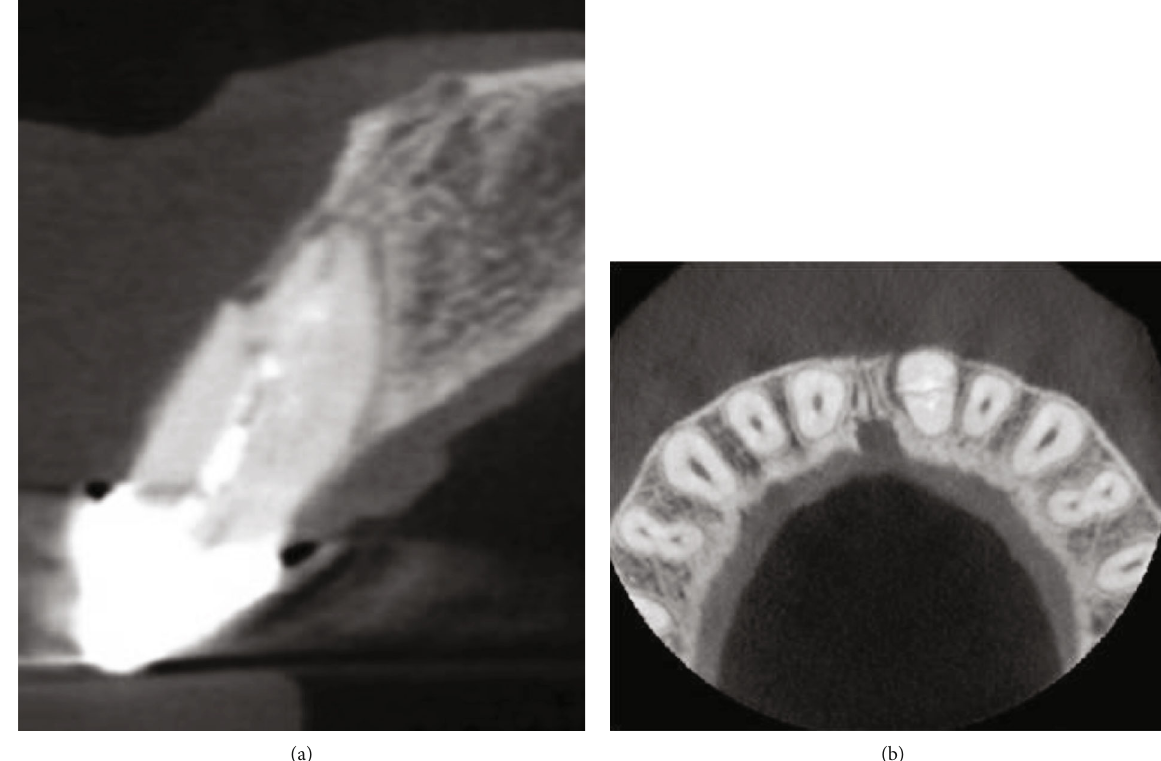
Figure 6: (a) After 6 months of follow-up on CBCT (axial view). (b) After 6 months on CBCT (sagittal